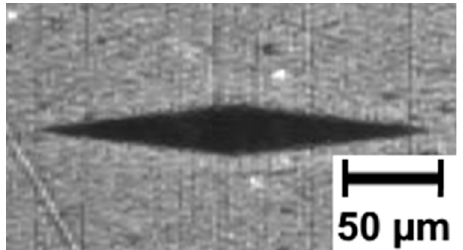
Figure 6. Imprint obtained from the Knoop microhardness test.